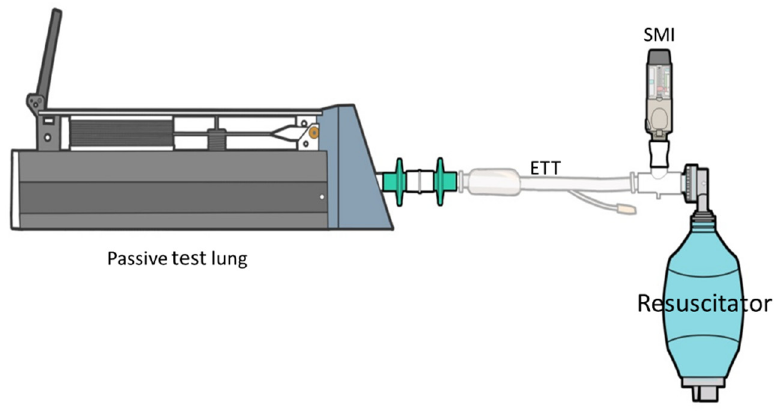
Figure 2. A soft moisture inhaler delivered through a T-adapter between the endotracheal tube and a manual resuscitator .